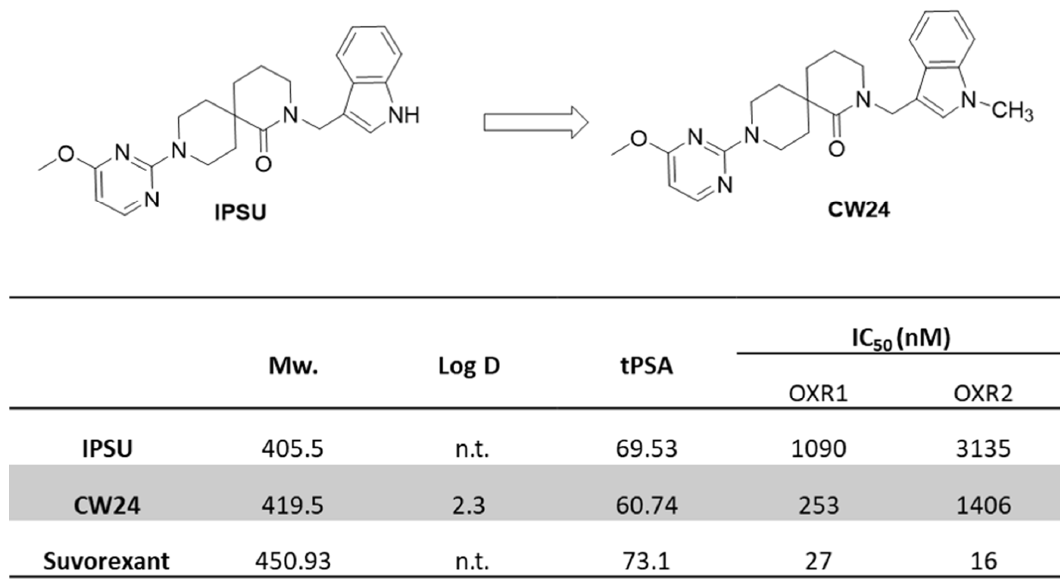
Figure 2. Structures and physicochemical properties of IPSU and CW24 (n.t. = not tested). IC50 of IPSU, CW24 and suvorexant were measured by a radioligand competition binding assay.